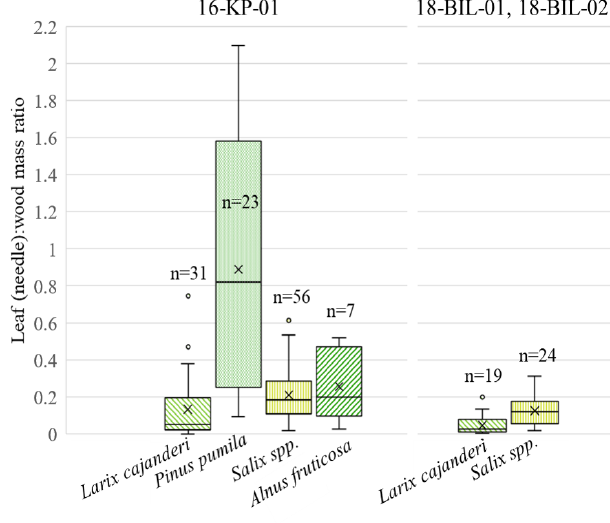
Figure 6. Distribution of leaf (needle)-to-wood dry mass ratio among studied species – Larix cajanderi , Pinus pumila , Salix spp. (non-creeping), and Alnus fruticosa – in two ecological regions – tundra–taiga ecotone (16-KP-01) and northern taiga (18-BIL-01, 18-BIL-02); n is number of individuals